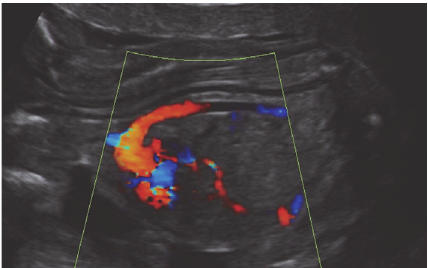
Figure 2: Longitudinal midsagittal view of the upper body of affected fetus. Flow in the aortic arch and descending thoracic aorta is shown by color flow mapping. No flow is visible inside the translucent tubular structure interpreted as the